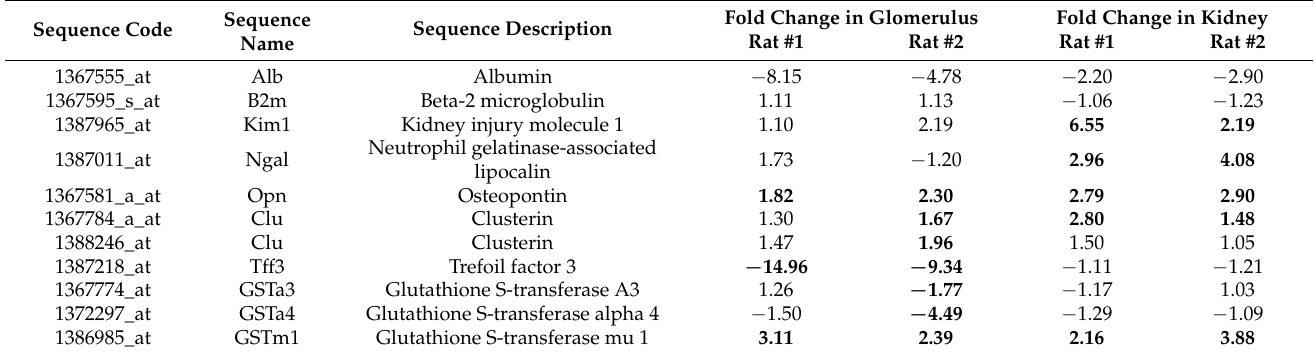
Table 2. Gene expression changes of urinary biomarkers in glomerular and kidney samples from rats treated with ABT- 123 at 10 mg/kg/day for seven days.